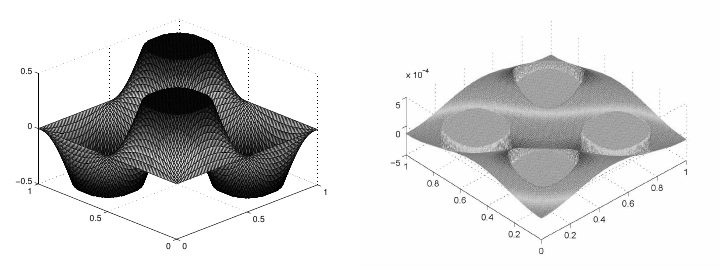
Figure 2. The exact solution u (left) and the error u − u h (right), Example 1.